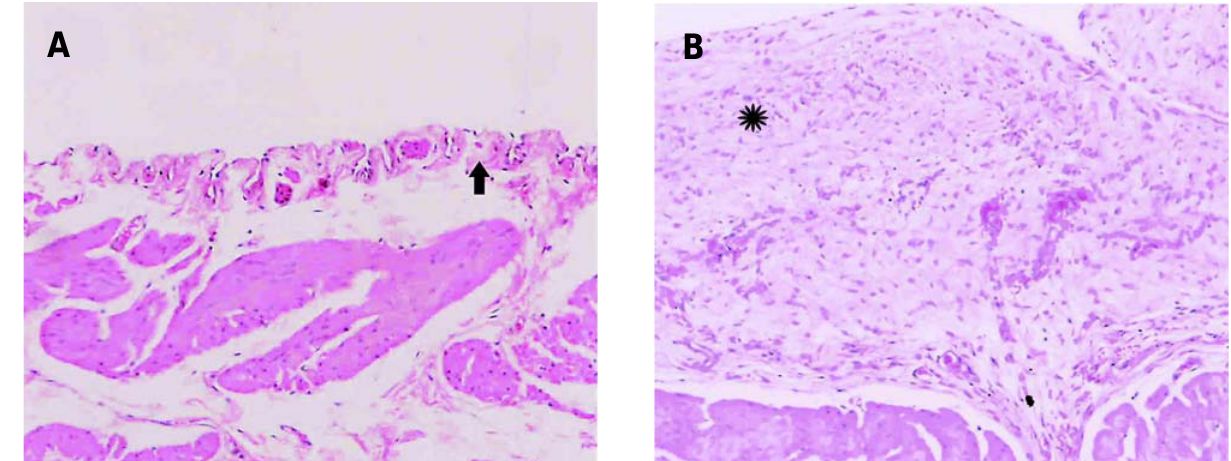
Figure 3 – Histological section of rabbit bladder. A) Absence of adventitial fibrosis in group G1 (arrow), HE X40. B) Intense adven- titial fibrosis in group G2 (asterisk), HE X100.